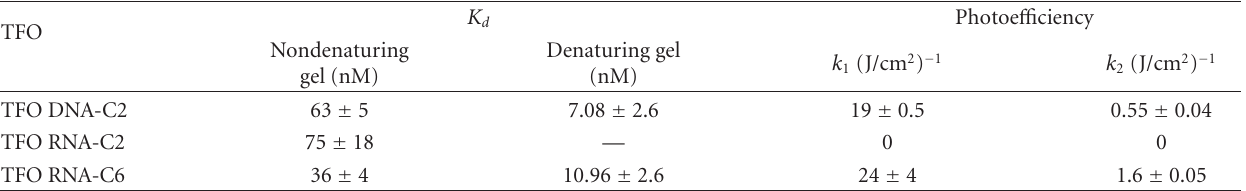
Table 1: Binding and photoreactive e ffi ciencies for TFOs conjugated to HMT.